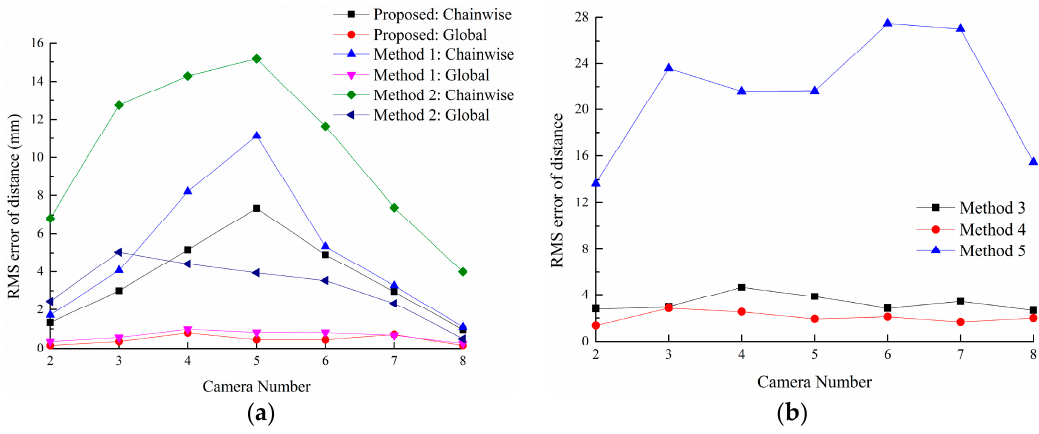
Figure 12. The distance error of each method. ( a ) RMS errors of the proposed method, Methods 1 and 2; ( b ) RMS errors of Methods 3, 4 and 5.